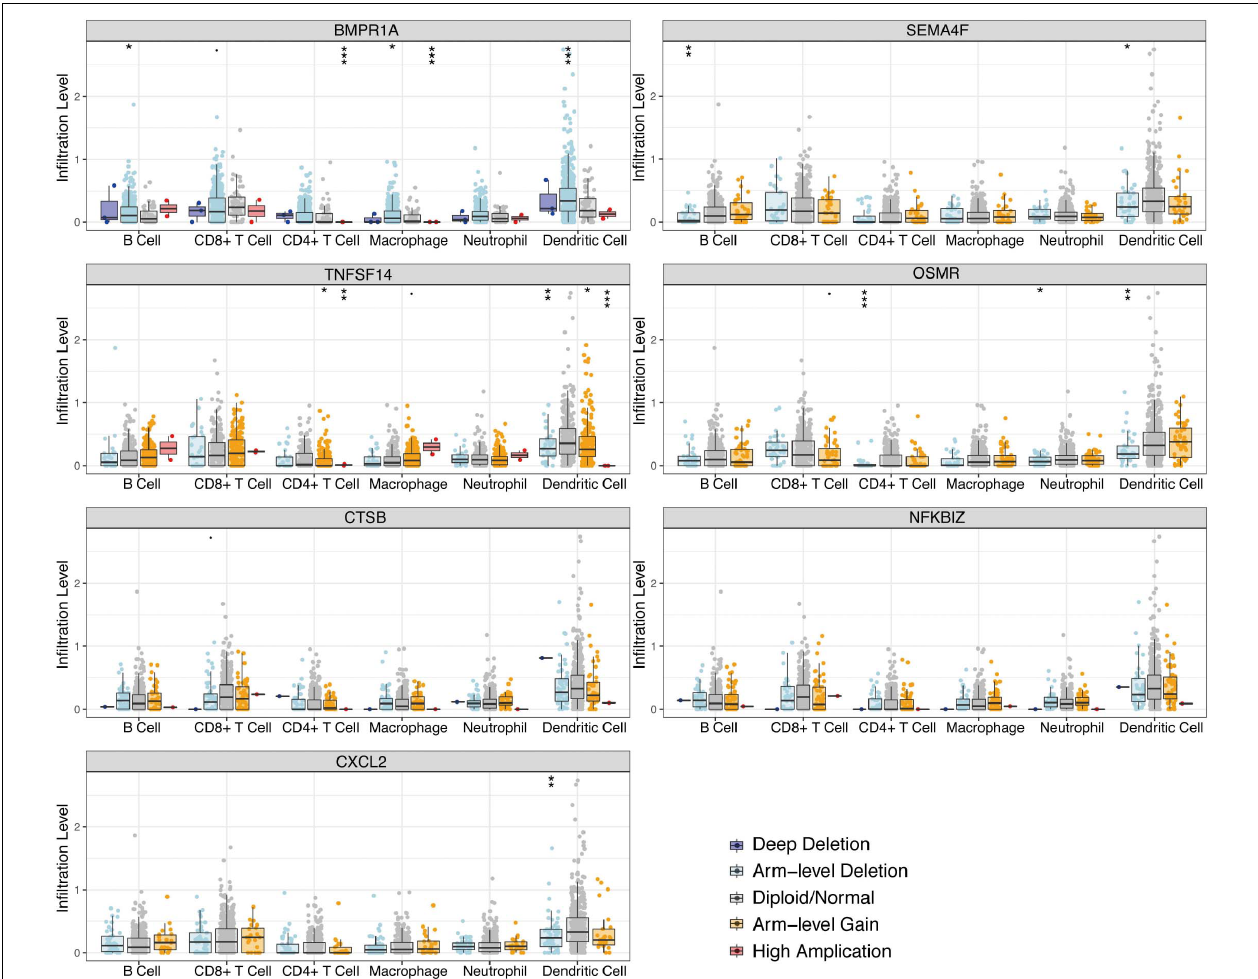
FIGURE 7 | Correlations of seven immune-related gene copy member with immune infiltration level in GBM. These seven-immune-related gene CNV affects the infiltrating levels of different immune cells in GBM. * p < 0.05, ** p < 0.01, *** p <